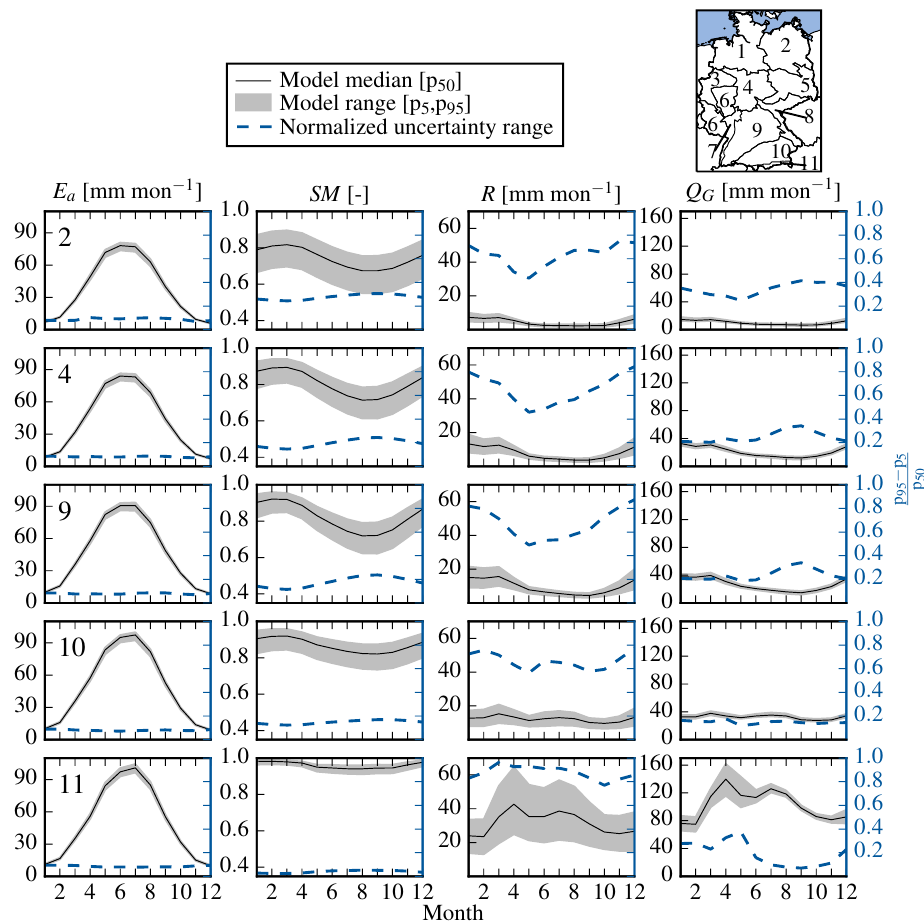
Figure 10. Spatiotemporal patterns of uncertainty for five different environmental zones in Germany. The locations of the different zones are depicted on the map on the upper right. The presented hydrologic variables are evapotranspiration ( E a ), soil moisture (SM), recharge ( R ), and grid-cell-generated runoff ( Q G ). The uncertainty ranges and the ensemble median refer to the left ordinate (black and gray), whereas the normalized uncertainty range refers to the right ordinate (blue). The reference period for the climatological values is